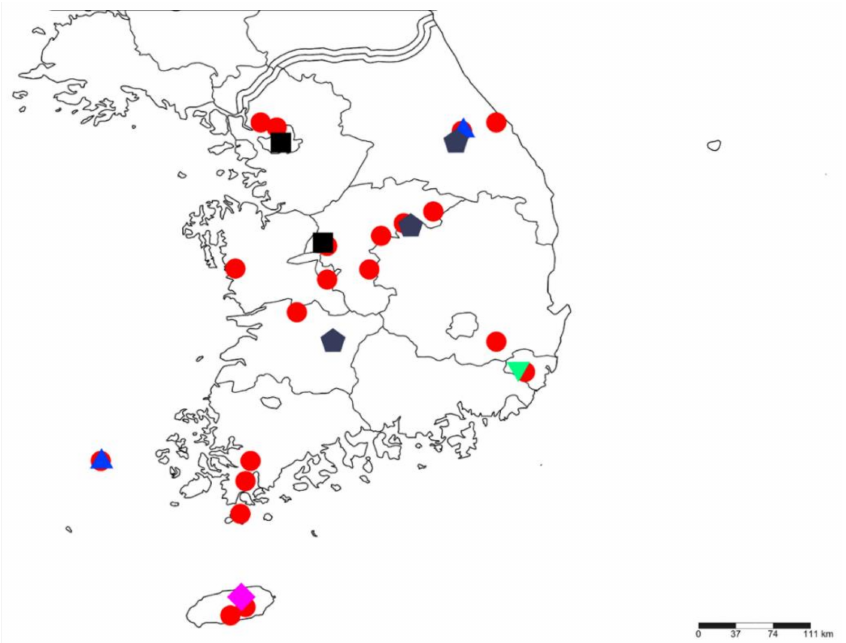
Figure 10. Collection localities in South Korea: Edaphus haenamensis sp.n. ( circle ); E. odaesanensis sp.n. ( triangle ); E. suyuensis sp.n. ( square ); E. ulsanensis sp.n. ( reverse triangle ); E. lederi ( diamond ); E. koreanus ( pentagon